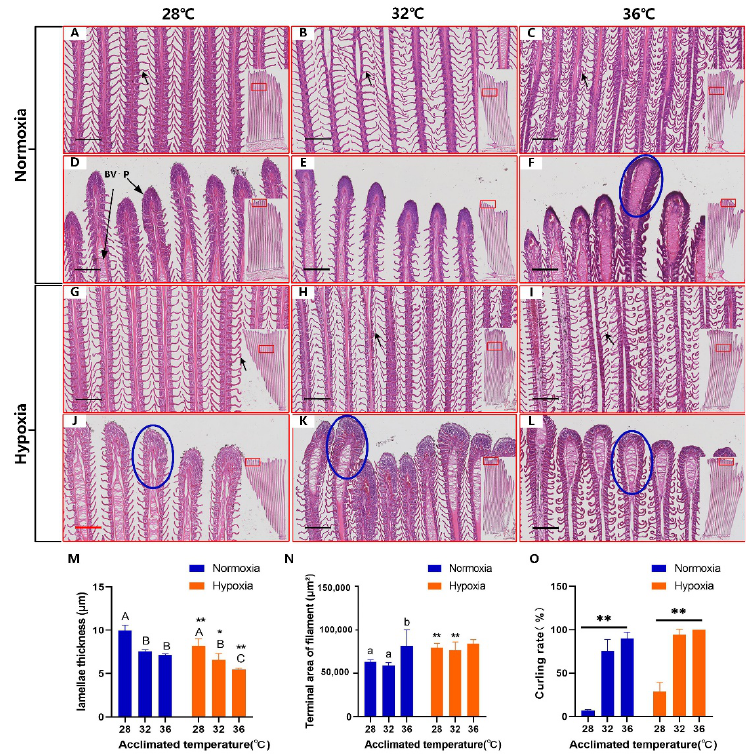
Figure 2. Morphological changes of gill tissue in GIFT tilapia after exposure to high temperature and hypoxia. Controls (28 °C, normoxia) demonstrated normal gill filaments ( A , D ). Fish kept at 32 and 36 °C displayed curling of the lamellae under normoxia ( B , C ) and acute hypoxia ( H , I ). ( G ) Curling lamellae in 28 °C hypoxia. The terminal area of the filament was normal at 32 °C normoxia, while this area was expanded at 36 °C under normoxia ( F ) and at 28, 32, and 36 °C under hypoxia ( J , K , L ), as indicated by the blue oval. The lower right corner of each photo displays the full view of the sagittal section of the gill slice; the red box indicates the enlarged area. Arrows indicate the lamellae. BV, blood vessel; P, primary filament. Bars = 200 µm. ( M ) Mean thickness of filaments. ( N ) The terminal area of the filament (area with diameter of 200 µm from the end, as demonstrated in ( F ). Displayed are the means ± SEM ( n = 5). Statistically significant differences between temperature treatments under normoxia or acute hypoxia are tested by one-way ANOVA, respectively, and the multiple comparisons are indicated with different lowercase ( p < 0.05) or capital letters ( p < 0.01). Significant differences between normoxia and acute hypoxia under the same temperature are indicated with single asterisks ( p < 0.05) or double asterisks ( p < 0.01). ( O ) Percentages of curling lamellae (%) at different temperature treatments. Percentage data were tested using Chi -squared tests; ** indicates p < 0.01.